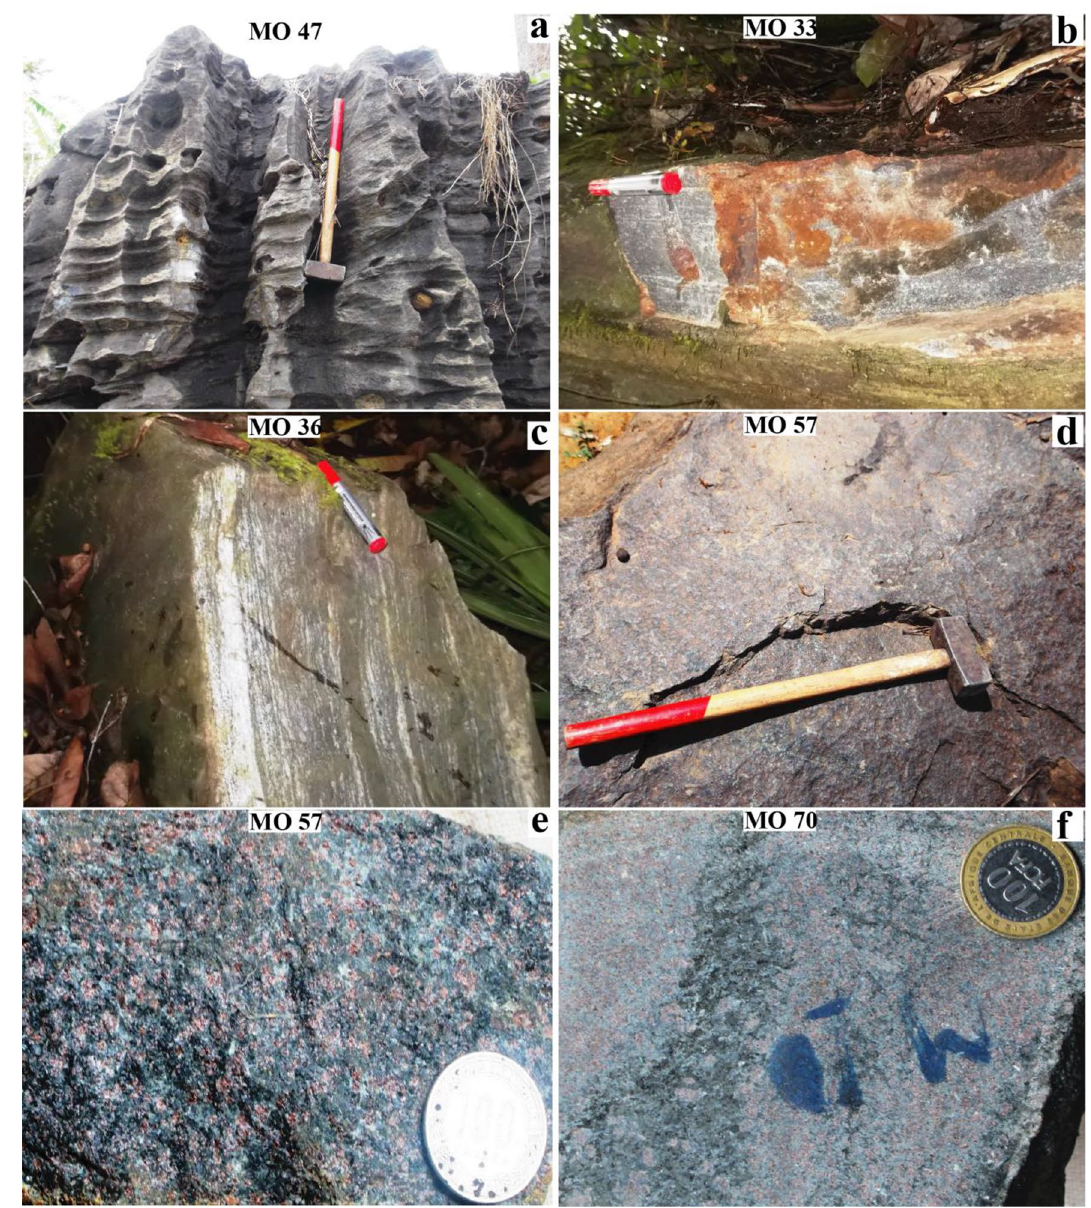
displaying steep foliation, e Hand-specimen of meta-mafic rocks displaying discontinuos tiny leucosome layers and leucosome pocket, f meta-mafic rocks displaying phenocrystals of garnet and